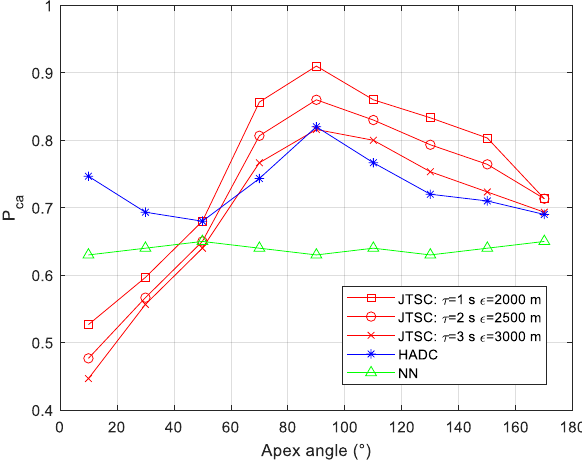
Figure 12. Probability of correct association vs. different apex angle.